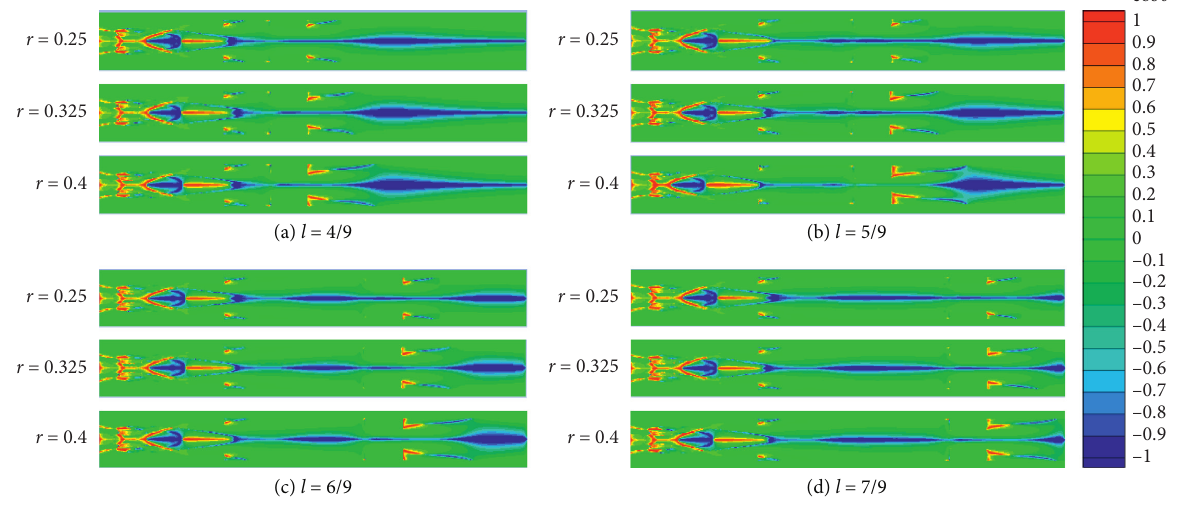
Figure 14: Cosine of field synergy angle at l � 4/9.